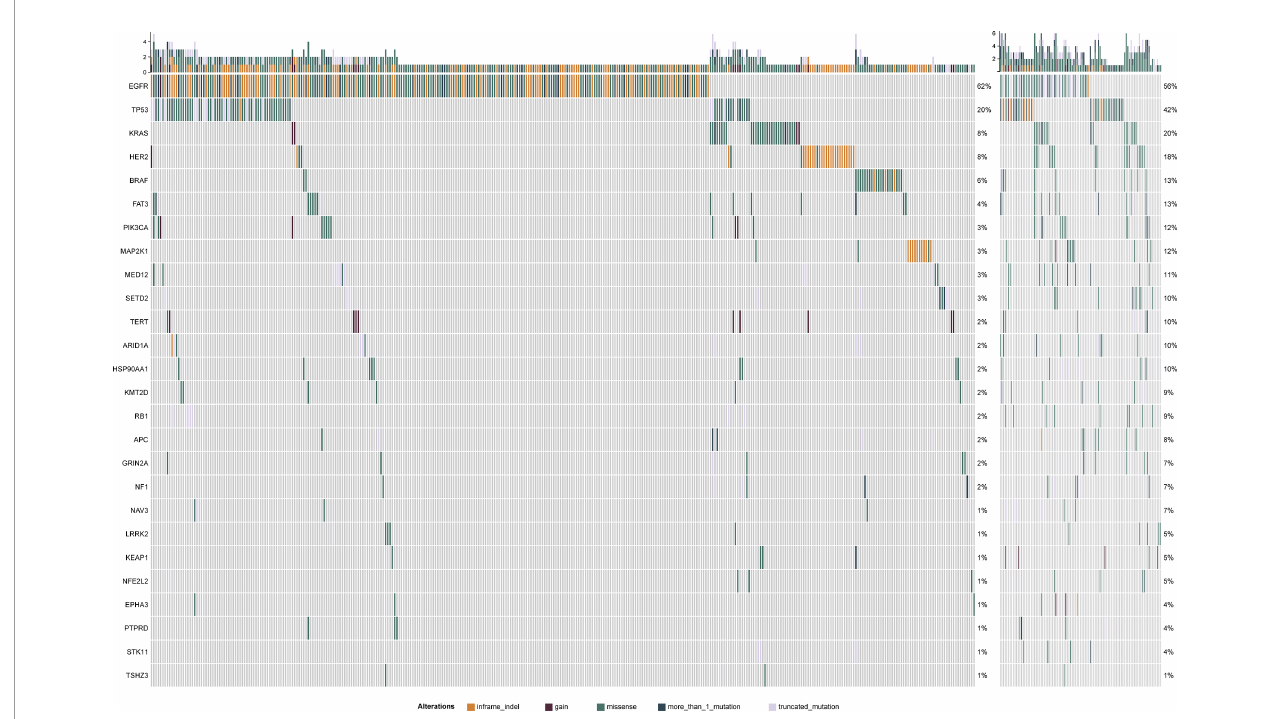
FIGURE 2 | The left panel is TMB-L mutation map and the right panel is TMB-H mutation map. Mutation ratio of different genes displays in left. Different mutation types have different color